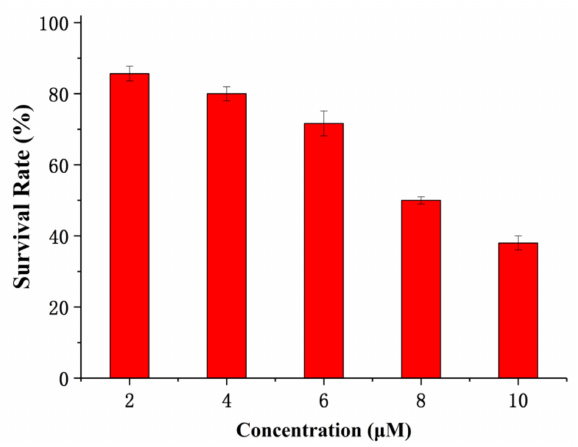
Figure 7. Cell viability by a standard CCK-8 assay. The experiment was repeated three times ( ± S.D.).